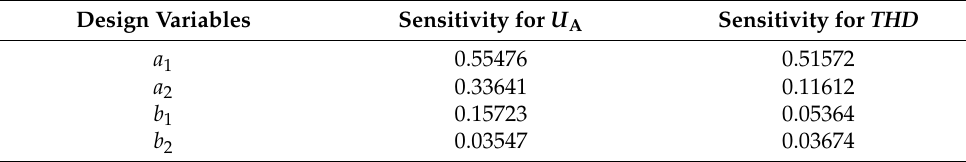
Table 4. Sensitivity of the design variable with respect to the response value. Design Variables